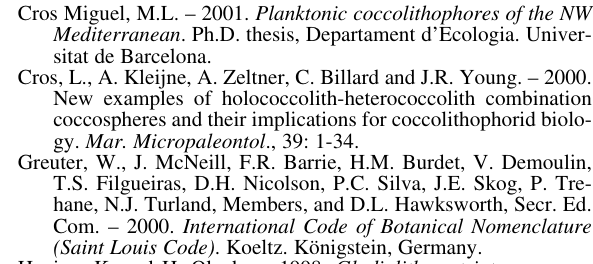
Holotype : Figure 2A. Negative 138910. Deposited in the ICM (CSIC) Barcelona. Type locality : 41º02.3N, 2º14.7E. Station 25WT, at 70 m depth, during the cruise Fronts-95 (NW Mediterranean). Etymology : The new species Picarola margalefii sp. nov., is dedi- cated to Dr. Ramon Margalef, who studied the phytoplankton of the NW Mediterranean and encouraged our coccolithophore studies in these